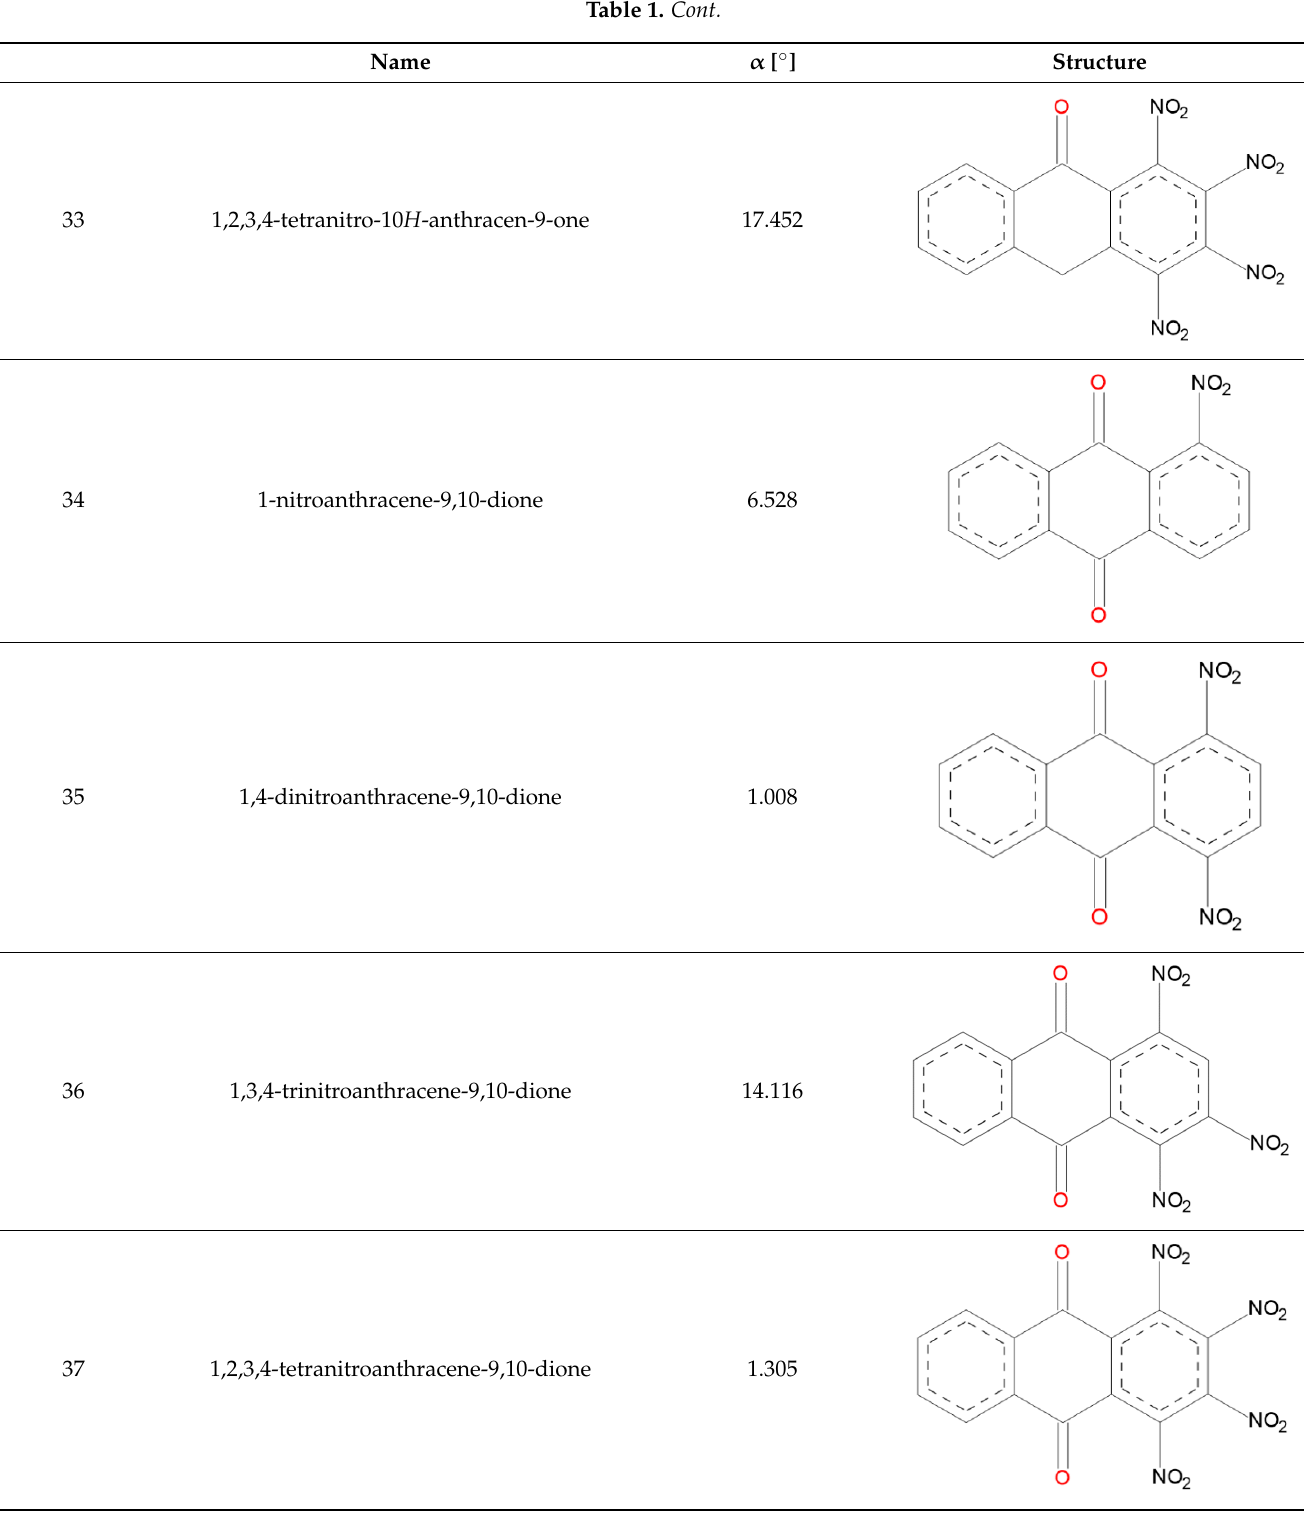
Table 2. β angle and C–N bond length for substituents in the aromatic side ring.